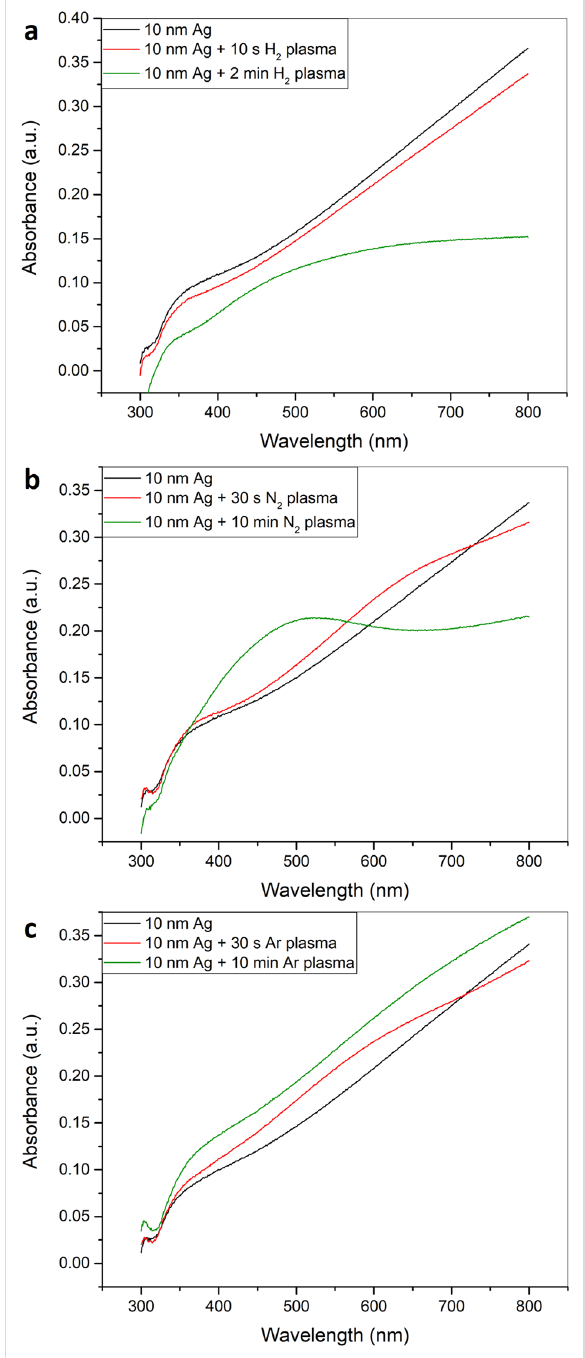
Figure 9: UV–vis spectra of 10 nm sputtered silver films treated with (a) hydrogen plasma, (b) nitrogen plasma and (c) argon plasma for dif- ferent times.